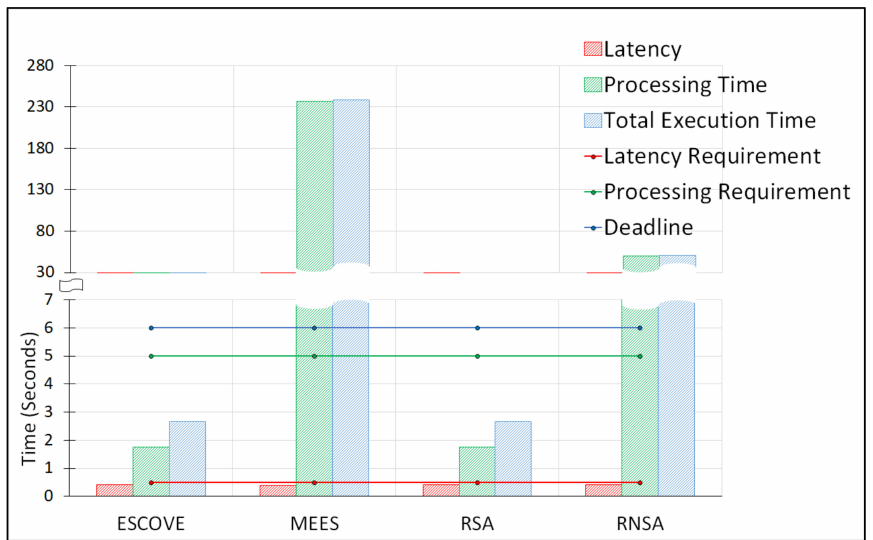
Figure 13. Average latency, processing and total execution times using ESCOVE, MEES, RSA, and